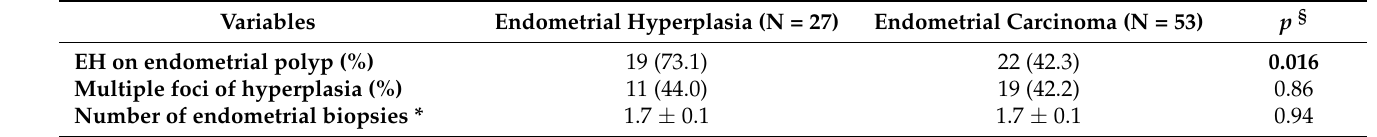
Table 5. Histopathologic pre-operative features of the endometrial lesions in the two